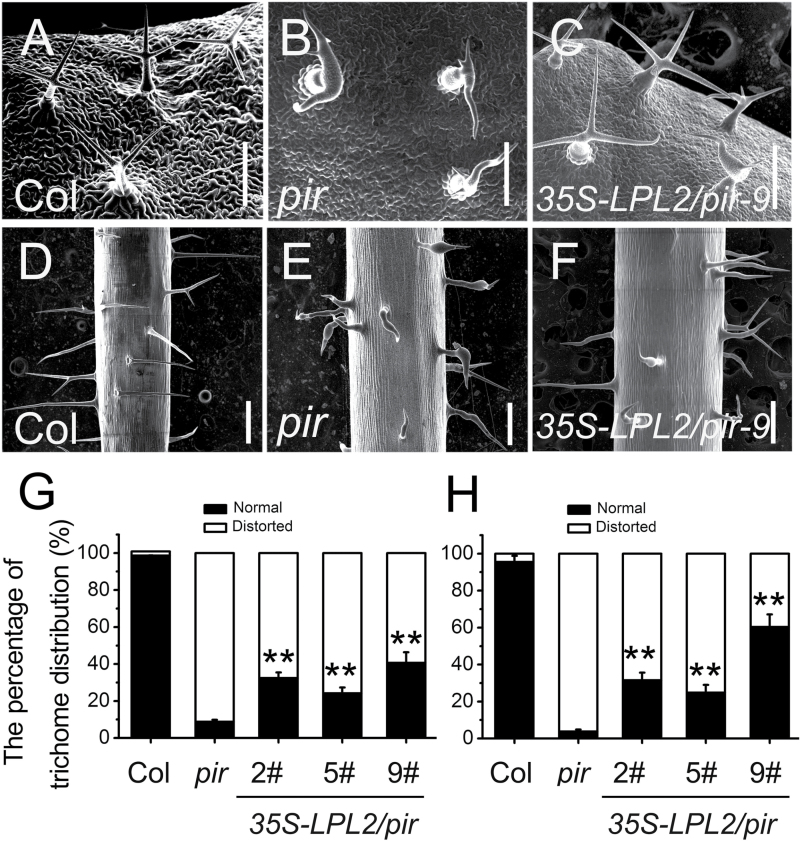
Overexpression of LPL2 could partially complement phenotypes of distorted trichomes in Arabidopsis pir. SEM images of trichomes on the adaxial leaf of Col (A), pir (B) and 35S-LPL2/pir-9# (C). Bars, 400 μm. SEM images of trichomes on the stem of Col (D), pir (E) and 35S-LPL2/pir-9# (F). Bars, 0.5cm. Panel A shows leaf trichomes on 2-week-old Col with three-branch shape; panel B shows pir exhibited defective trichomes; panels D, E show stem trichomes are straight in Col, but distorted in pir, respectively. The percentage of trichomes with normal or abnormal morphology on the leaf epidermis (G) and stem epidermis (H). n>100. Error bars represent SD. **, P<0.01 (Student’s t-test).